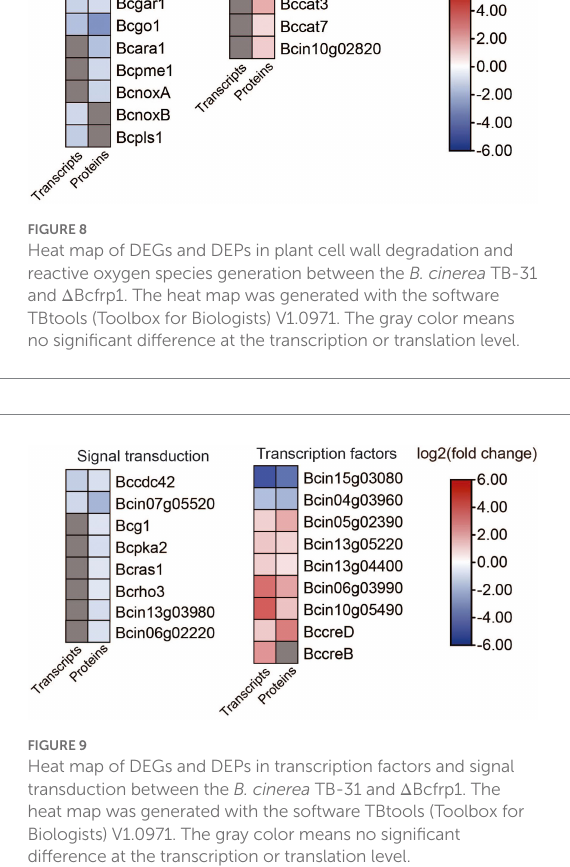
FIGURE 9 Heat map of DEGs and DEPs in transcription factors and signal transduction between the B. cinerea TB-31 and Δ Bcfrp1. The heat map was generated with the software TBtools (Toolbox for Biologists) V1.0971. The gray color means no significant difference at the transcription or translation